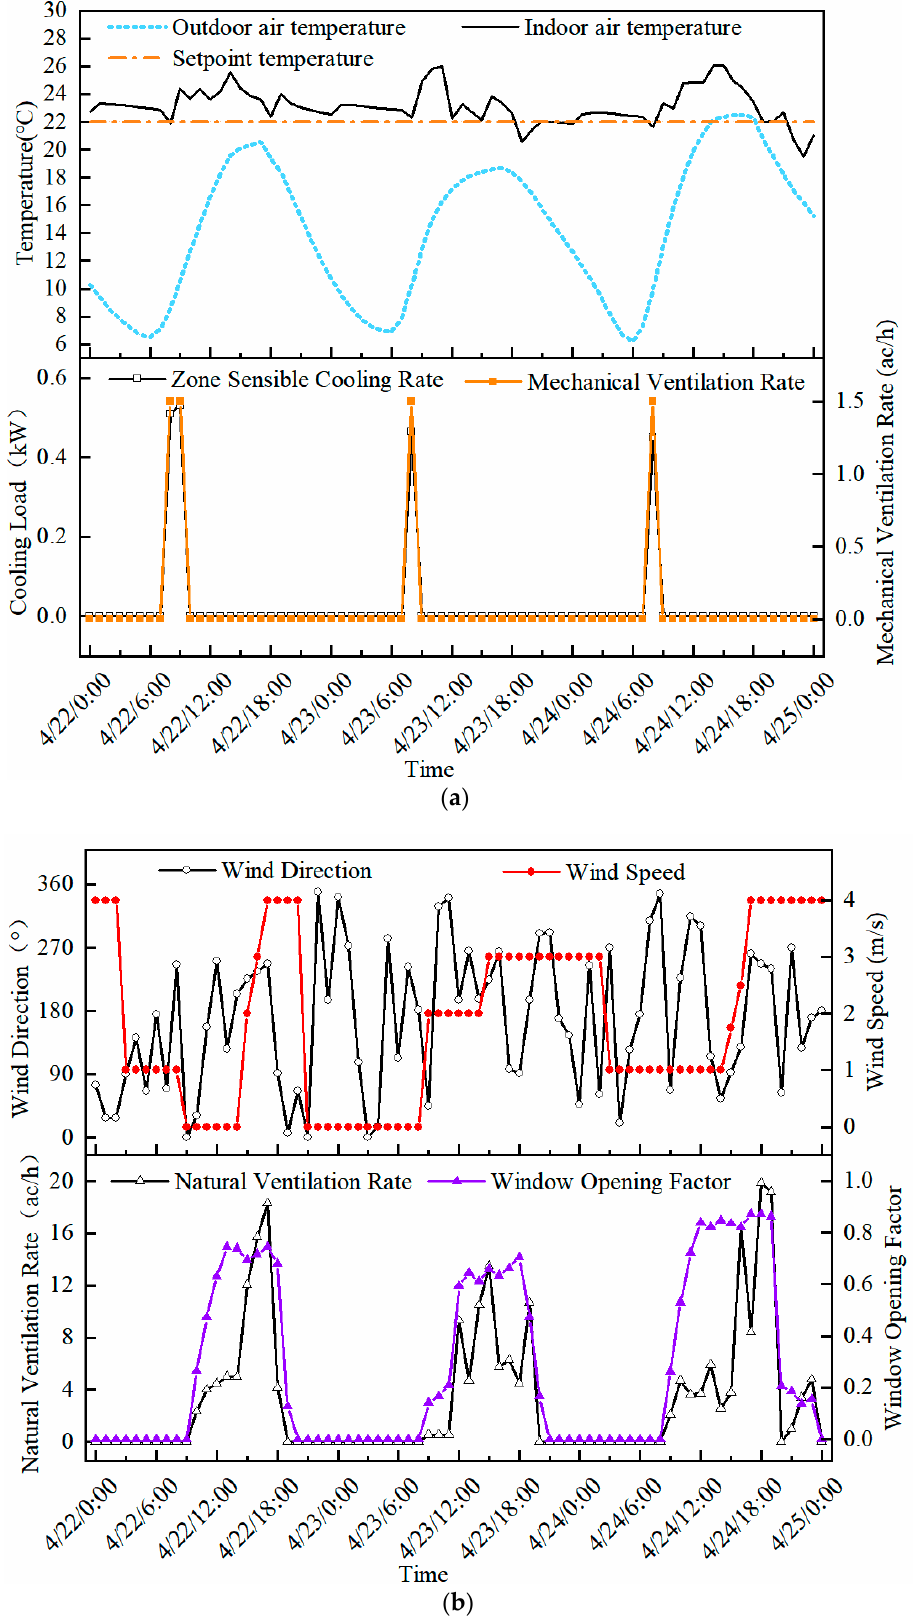
Figure 11. ( a ) Predicted space temperatures, cooling loadand; ( b ) airflow rates during 3 days in April (hybrid mechanical and natural ventilation mode).